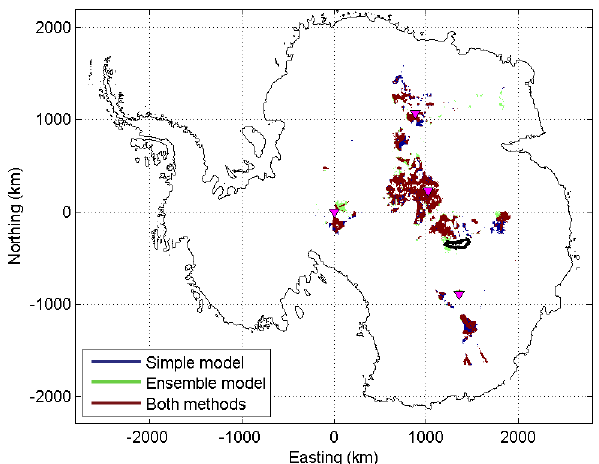
Fig. 8. Potential locations of cold basal conditions in areas with ice thickness H > 2000m, and horizontal flow speeds < 2myr − 1 locations of cold basal conditions in areas with ice thickness H > 2000 m, and Fig. 8. Potential according to the simple model (depicted in Fig. 5) and the ensemble horizontal flow speeds < 2 m yr -1 according to the simple model (depicted in Fig. 5) and the model (depicted in Fig. ensemble model (depicted in Fig. 7).